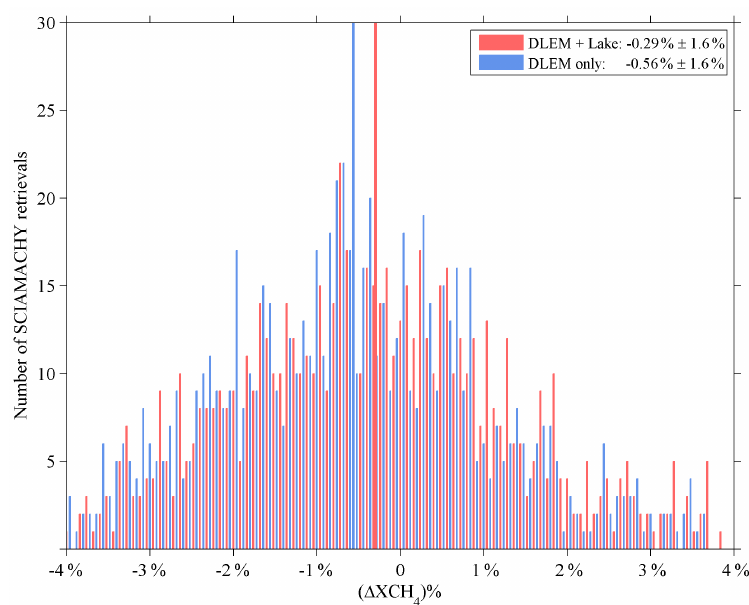
Figure 6. Distribution of the relative difference between the observed and simulated posterior SCIAMACHY column-average mixing ratios. The “DLEM + lake” scenario includes CH 4 emissions from both wetlands and lakes, and the “DLEM-only” scenario only includes CH 4 emissions from wetlands. Relative difference is calculated as a percentage of absolute differences between GEOS-Chem and SCIAMACHY relative to SCIAMACHY retrievals. Two extending red and blue lines represent the means of the simulation bias under the DLEM + lake scenario and the DLEM-only scenario,